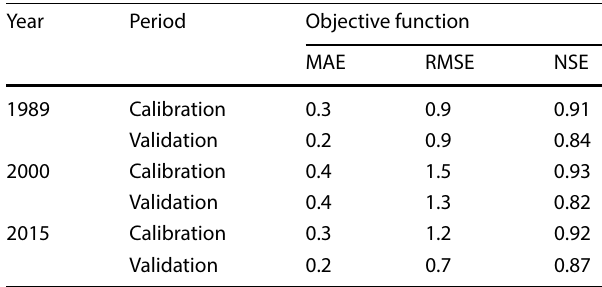
Table 10 Model performance measurements during runoff simula-